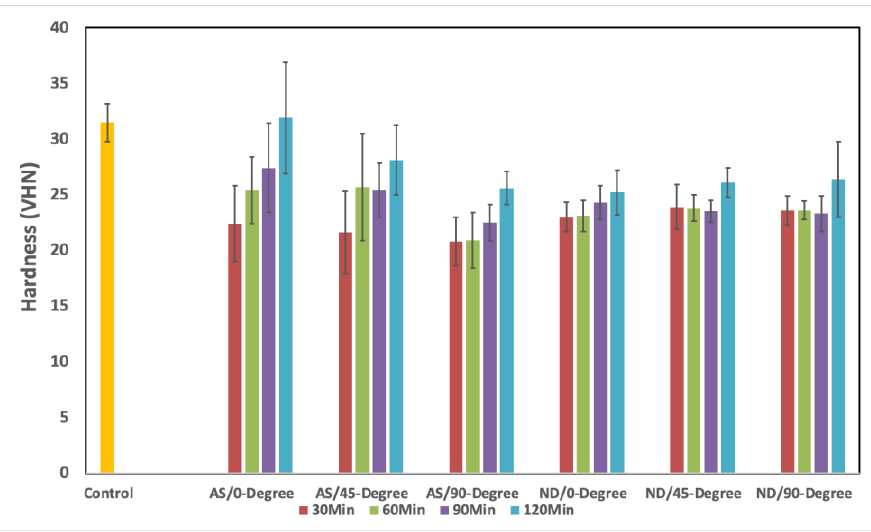
Figure 6. Mean and SD of hardness (VHN) of all tested groups. Table 4. Two-way ANOVA for combined effect of orientation and post-curing time on the hardness of each